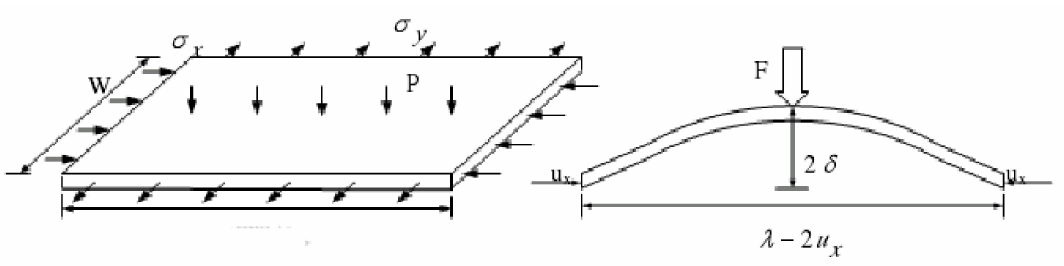
Figure 2. Schematic of DMV thin shell